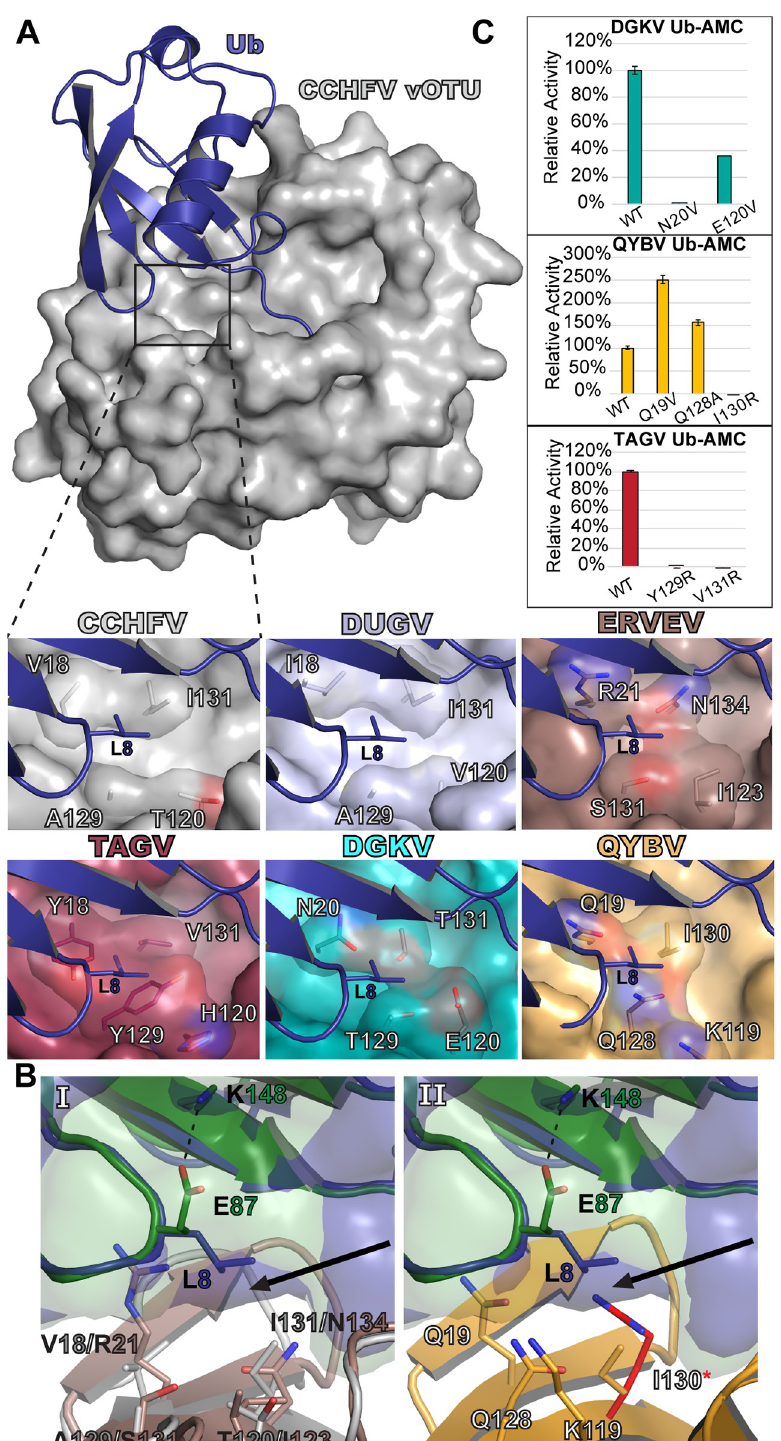
Fig 5. Selectivity pocket of nairovirus vOTUs. (A) The CCHFV vOTU Ub bound structure (PDB ID 3PRP) is shown with the location of the selectivity pocket indicated with a box. The selectivity pockets of the other vOTUs are shown, with the Ub (purple) modeled in from the CCHFV structure based on a secondary alignment of the vOTUs. DUGV vOTU (PDB ID 4HXD) is colored silver and ERVEV vOTU (PDB ID 5JZE) is colored brown. The other vOTUs are colored as in Fig 3. All models were generated by aligning the vOTUs with the CCHFV vOTU Ub bound structure